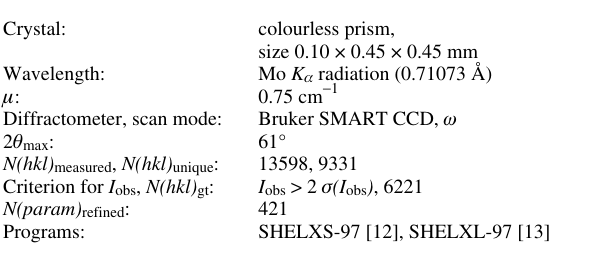
Table 1. Data collection and